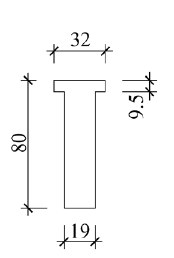
Figure 3. Dimensions of stud bolt connector, in mm.